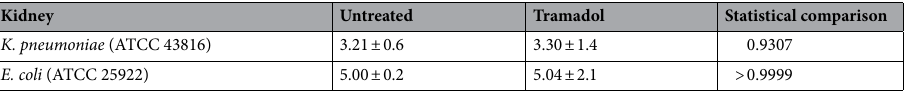
Table 3. Bacterial burden in kidney tissue. Median bacterial burden as well as standard deviation expressed as log 10 cfu/g tissue in kidney for the untreated and the tramadol-treated group for K. pneumoniae ATCC 43816 and E. coli ATCC 25922. Statistical testing was performed using a Kolmogorov–Smirnov test. P values are indicated in the respective